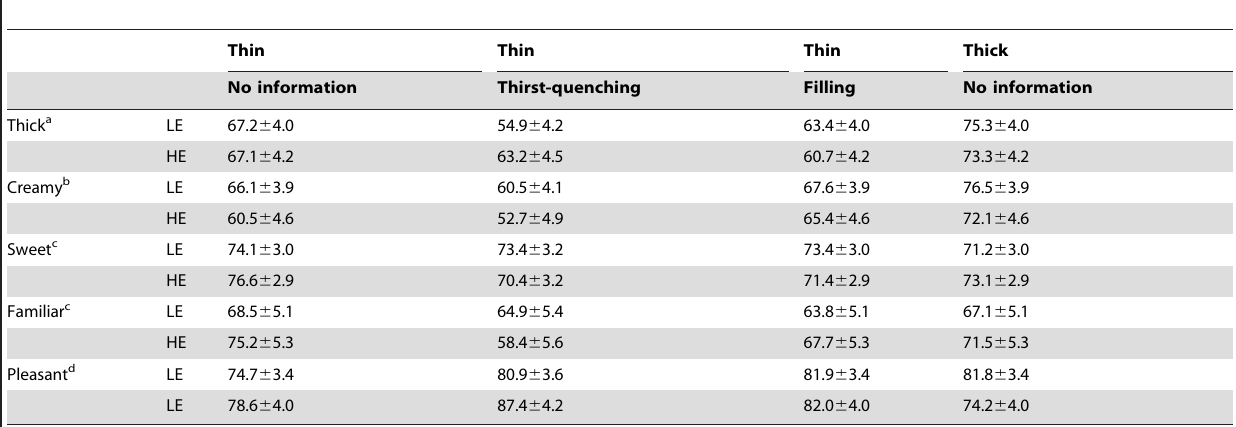
Table 3. Mean ( 6 SEM) sensory ratings of the higher- and lower- energy test drinks in each beverage context condition.